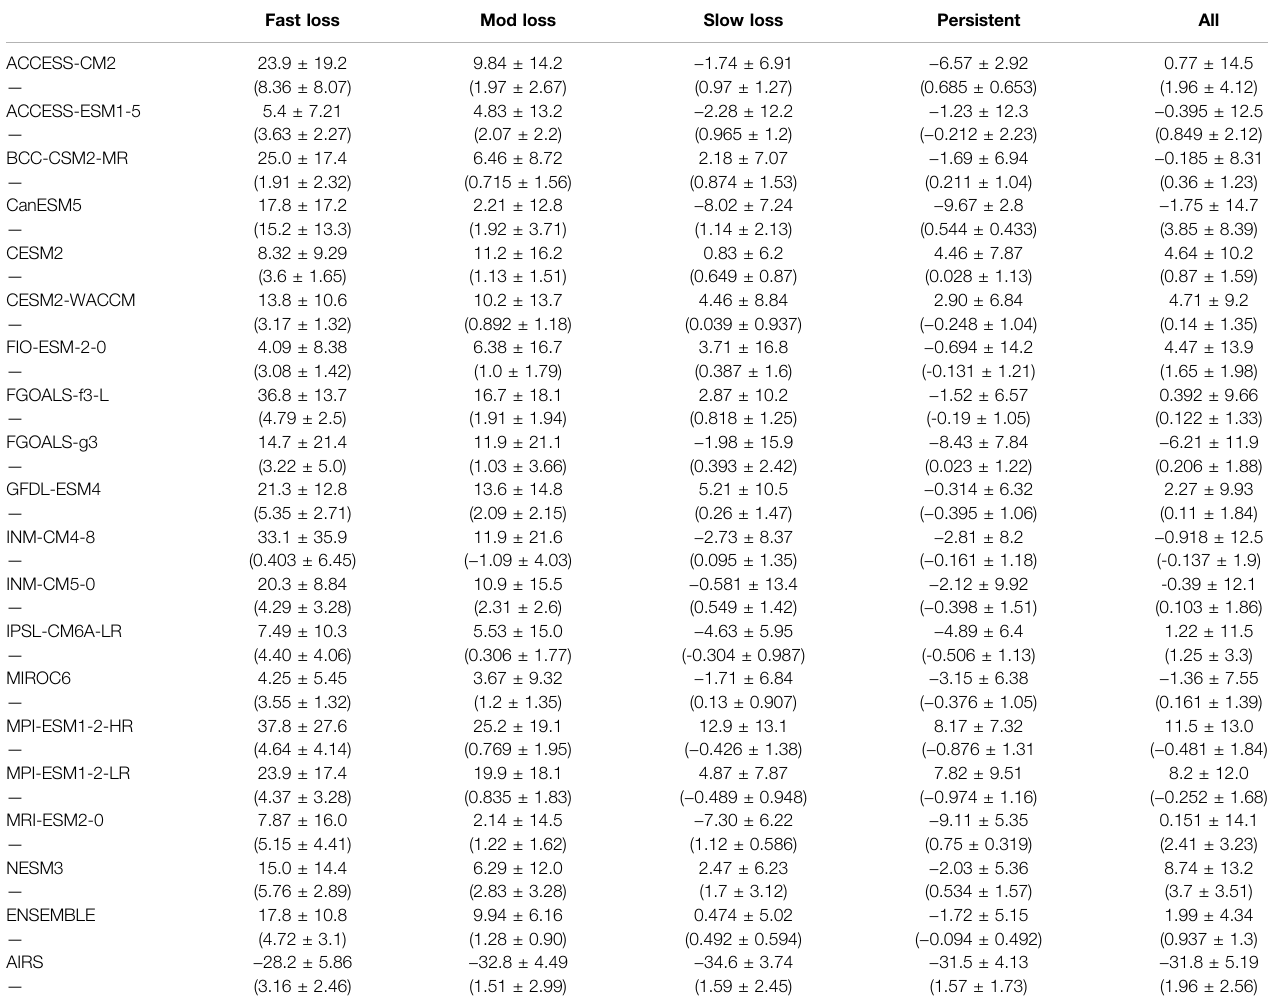
TABLE 2 | Summary of mean values and their standard deviation (decadal trends and their standard deviations in parenthesis) for AIRS-derived and CMIP6 models SHF for October-January 2002 – 2020. Values are strati fi ed by Arctic sea ice loss